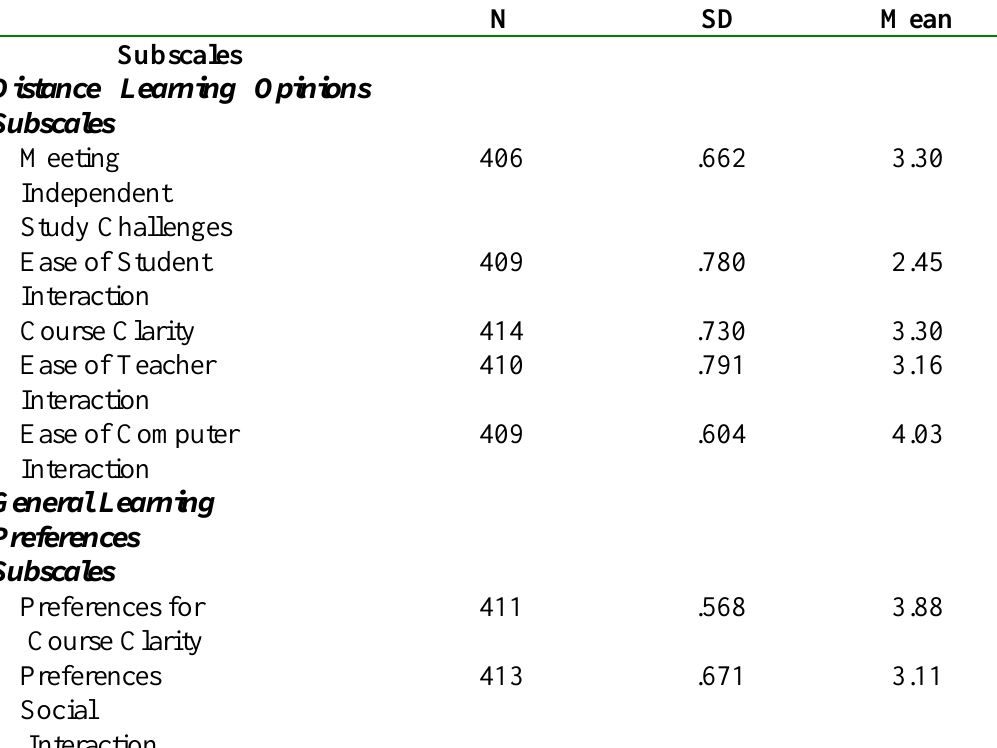
Table A5. Descriptive data – subscale means and standard deviation N